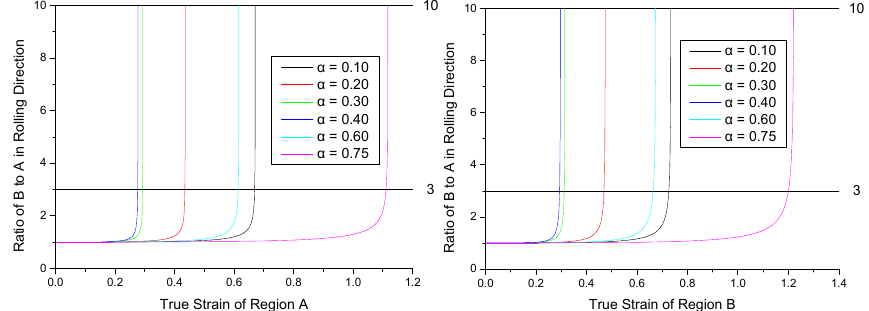
Figure 8. The relationship between the equivalent strain and the ratio of the strain increment of zone B and A.